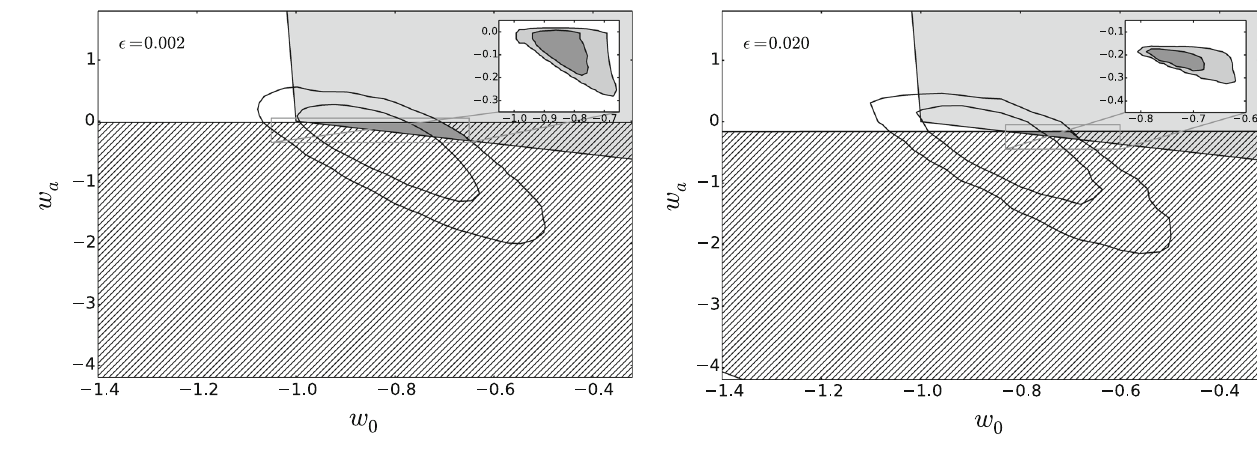
Fig. 4 The same as in Fig. 3 for P2 with (cid:7) = 0 . 002 and (cid:7) = 0 . 02